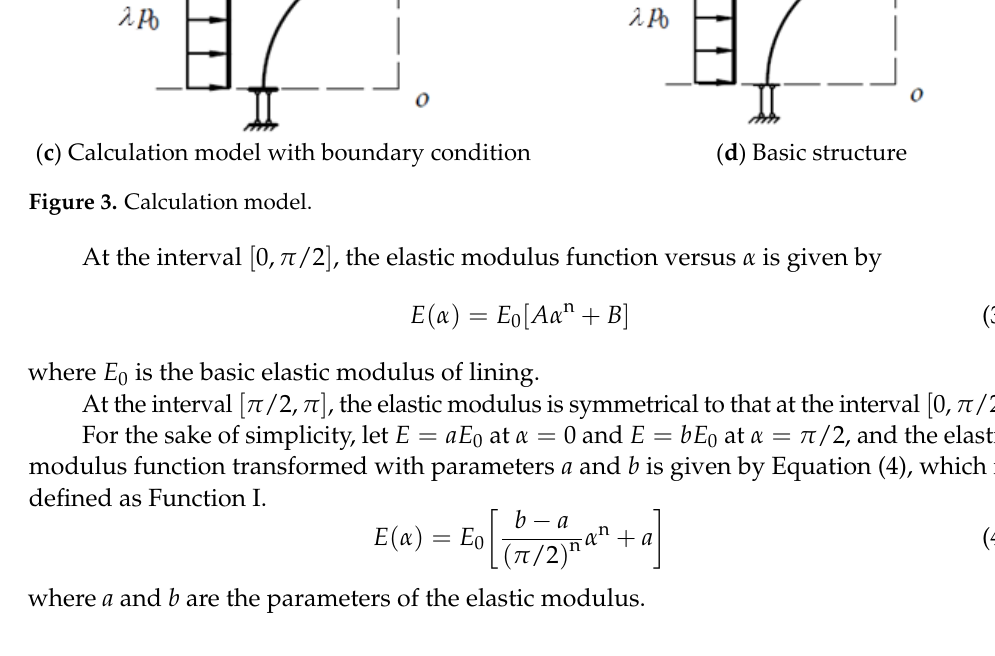
Figure 3. Calculation model.